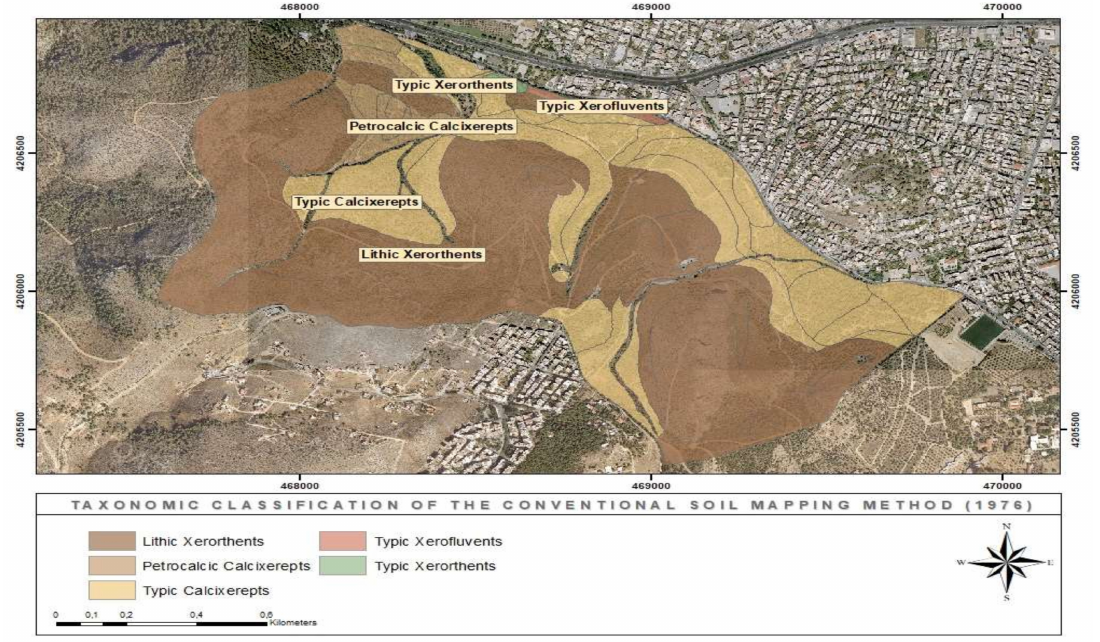
Figure 8. Soil taxonomic units (Subgroups) according to the conventional mapping methodology